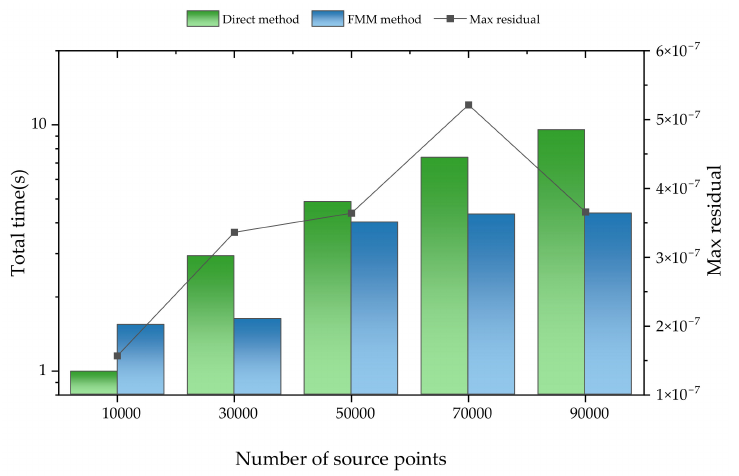
Figure 4. Comparison of the fast evaluation method and the direct evaluation method with different amounts of interpolation points (when the number of evaluation points is 10,000).